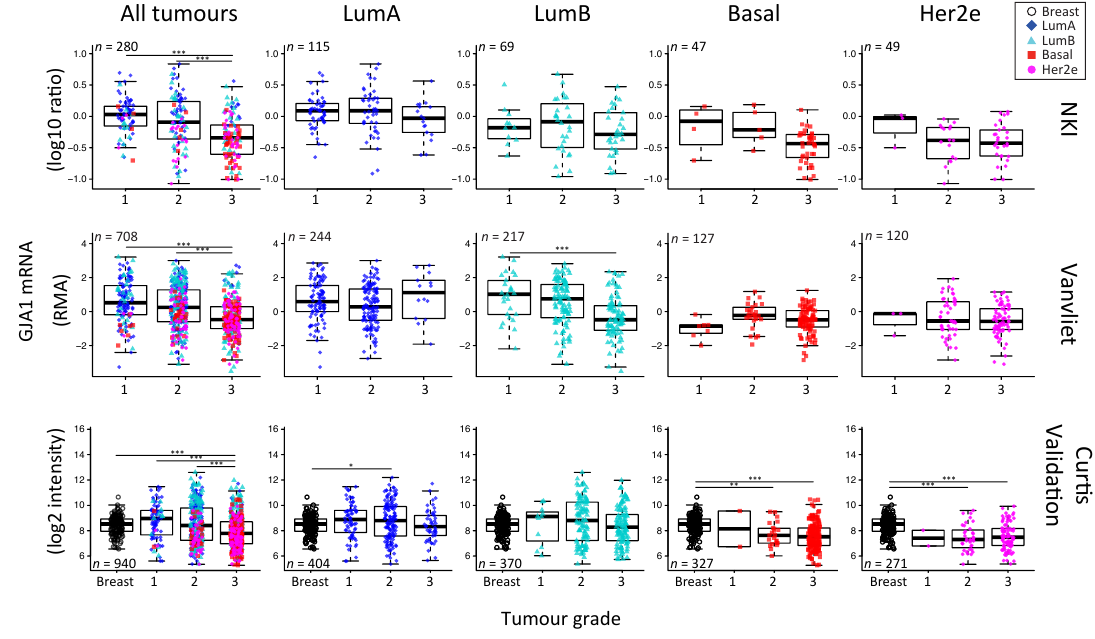
Figure A6. GJA1 mRNA level is reduced with grade in breast cancer clinical samples but only in pooled tumors. GJA1 mRNA level for each tumor grade, in Vanvliet, NKI and Curtis Validation datasets, either in pooled breast tumors or stratified by intrinsic subtype. In the legend, “Breast” indicates adjacent normal breast tissue. p value: * <0.05; ** <0.01; ***